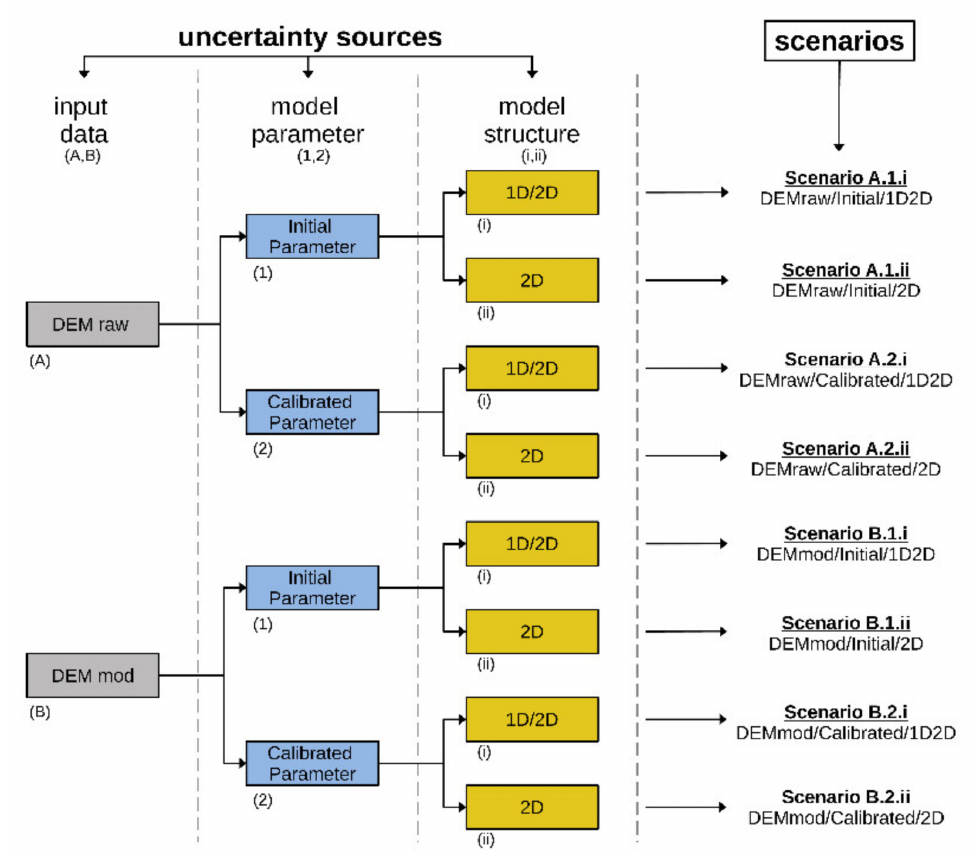
Figure 1. The model scenarios used to identify the highest-impact uncertainty source (input data: DEM raw ( A ), DEM mod ( B ); model parameter: initial parameter set-up ( 1 ), calibrated parameter set-up ( 2 ) and model structure: integrated 1D/2D ( i ), only 2D ( ii